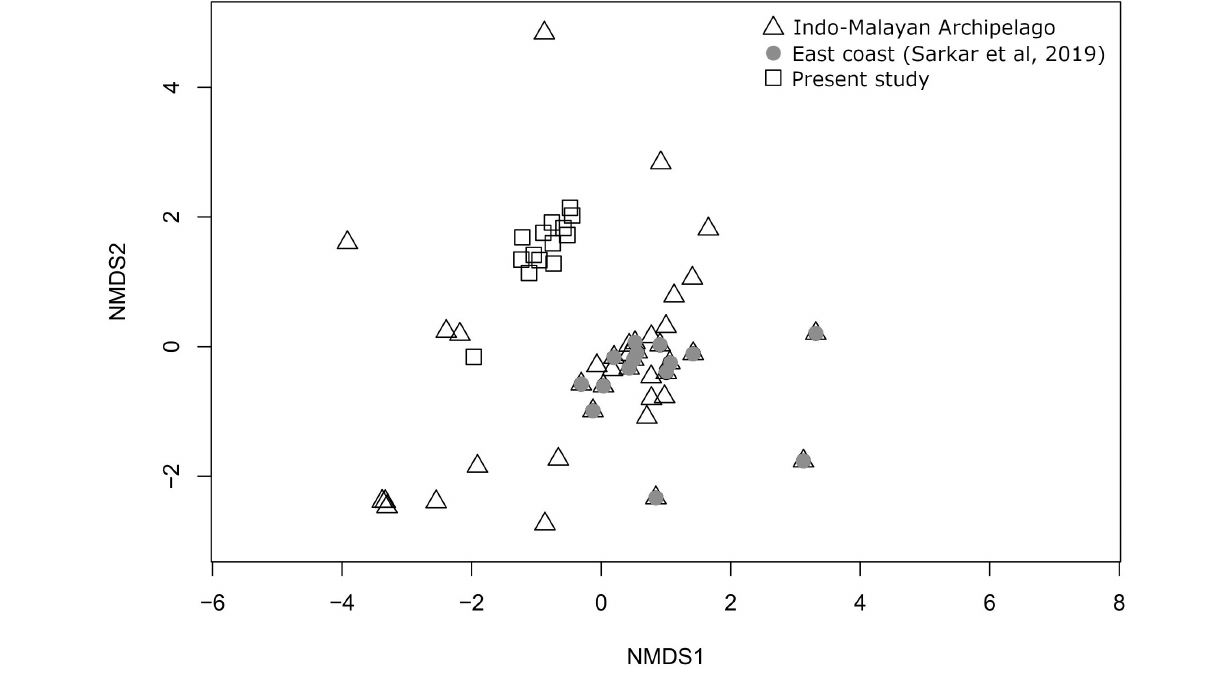
Frontiers in Marine Science |